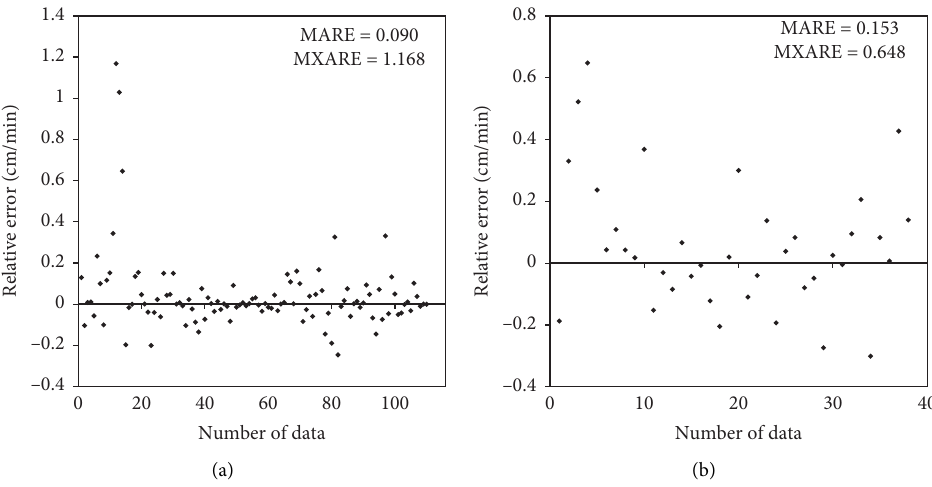
Figure 8: Relative error plots for the ANN model for the training and testing